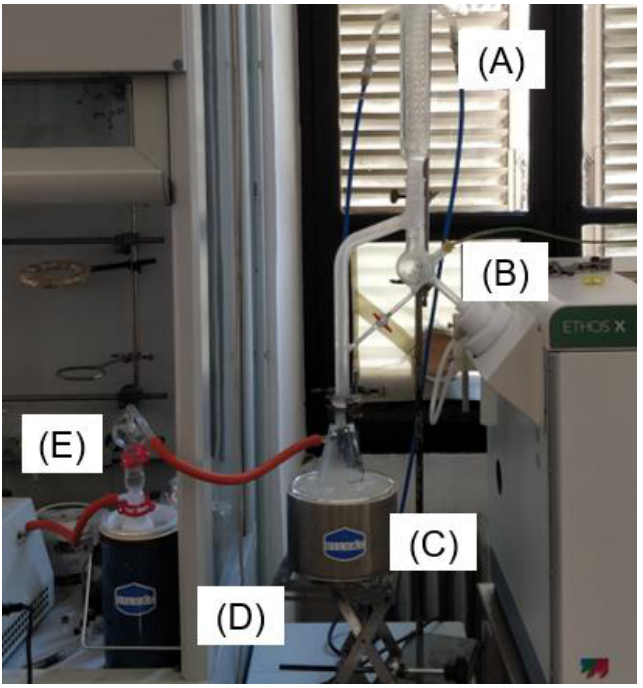
Figure 2. ETHOS X vacuum set-up; (A) condenser, (B) thermocouple, (C) collecting flask, (D) liquid-nitrogen trap, (E) pump.